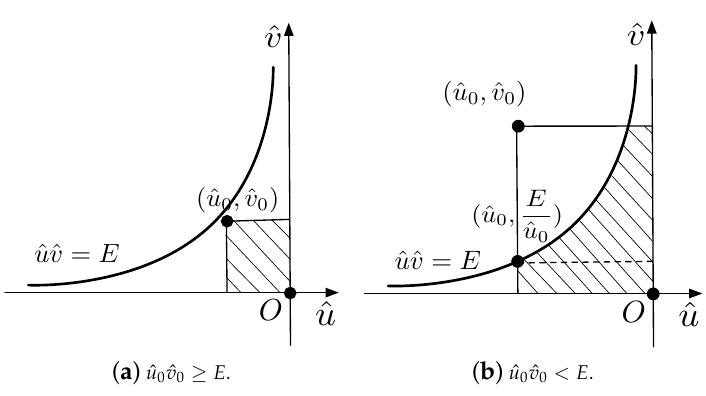
Figure 6. Illustrations of function values k −− + ( E , ˆ u 0 , ˆ v 0 ) if E < 0, ˆ u 0 < 0, and ˆ v 0 >